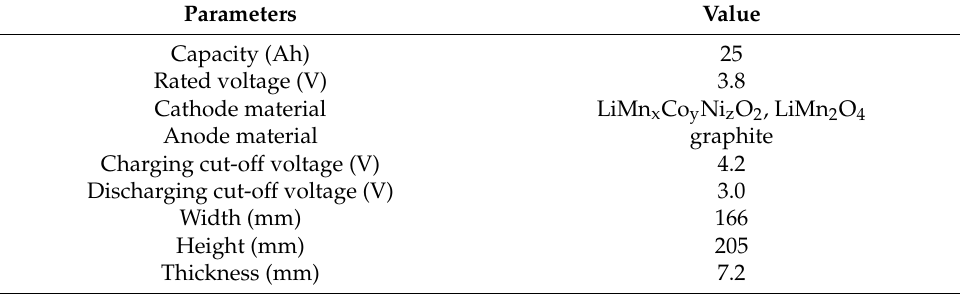
Table 2. Basic parameters of the cell